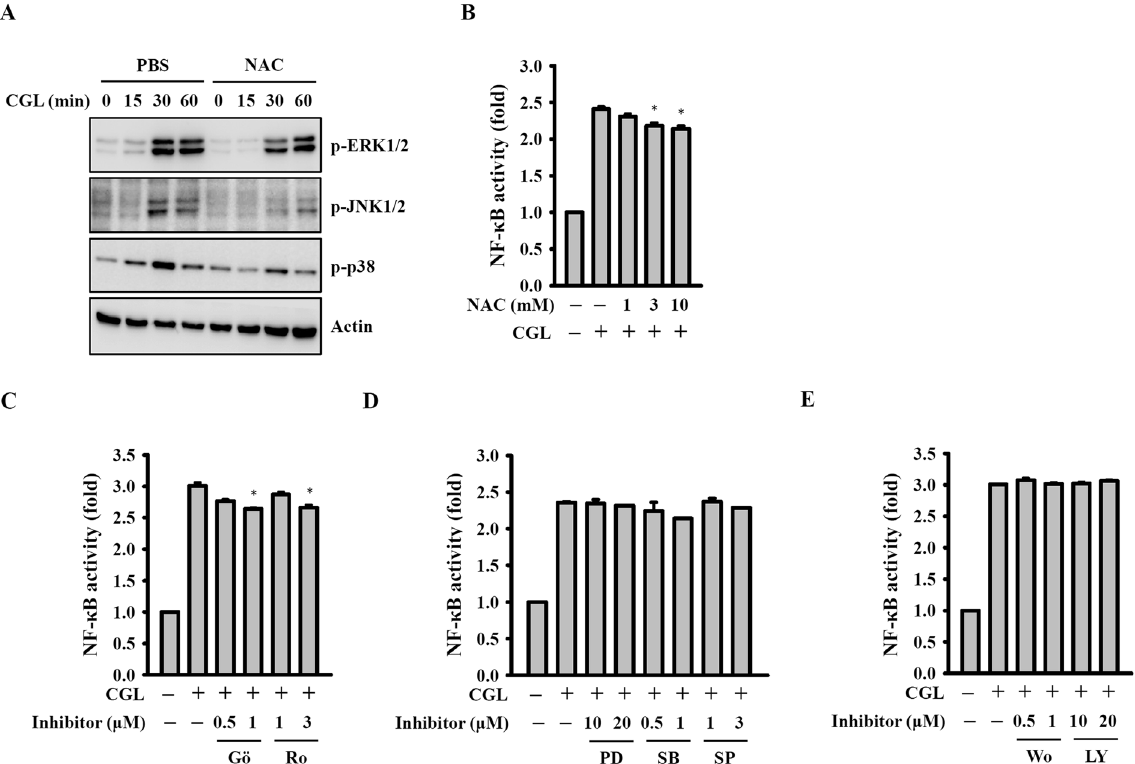
Figure 6. ROS acted upstream of MAPK in CGL-activated macrophages. ( A ) RAW264.7 macrophages were incubated for 30 min with or without NAC (10 mM) and then for 0–60 min with or without CGL (10 µ g/ml). The phosphorylation levels of ERK1/2, JNK1/2 and p38 were assayed by Western blot. ( B–E ) RAW-Blue TM cells were incubated for 30 min with or without NAC ( B ), MAPK inhibitor ( C ), PKC α / δ inhibitor ( D ) or PI3-kinase inhibitor ( E ), followed by incubation for 24 h with or without CGL (10 µ g/ml). The activation levels of NF- κ B were measured by NF- κ B reporter assay. Western blot results are representative of those obtained in three different experiments. The NF- κ B data is expressed as the means ± SD of three separate experiments. * Indicates a significant difference at the level of p < 0.05 compared to CGL-treated cells. The blots in (A) were cropped; full-length blots are included in the “Supplementary